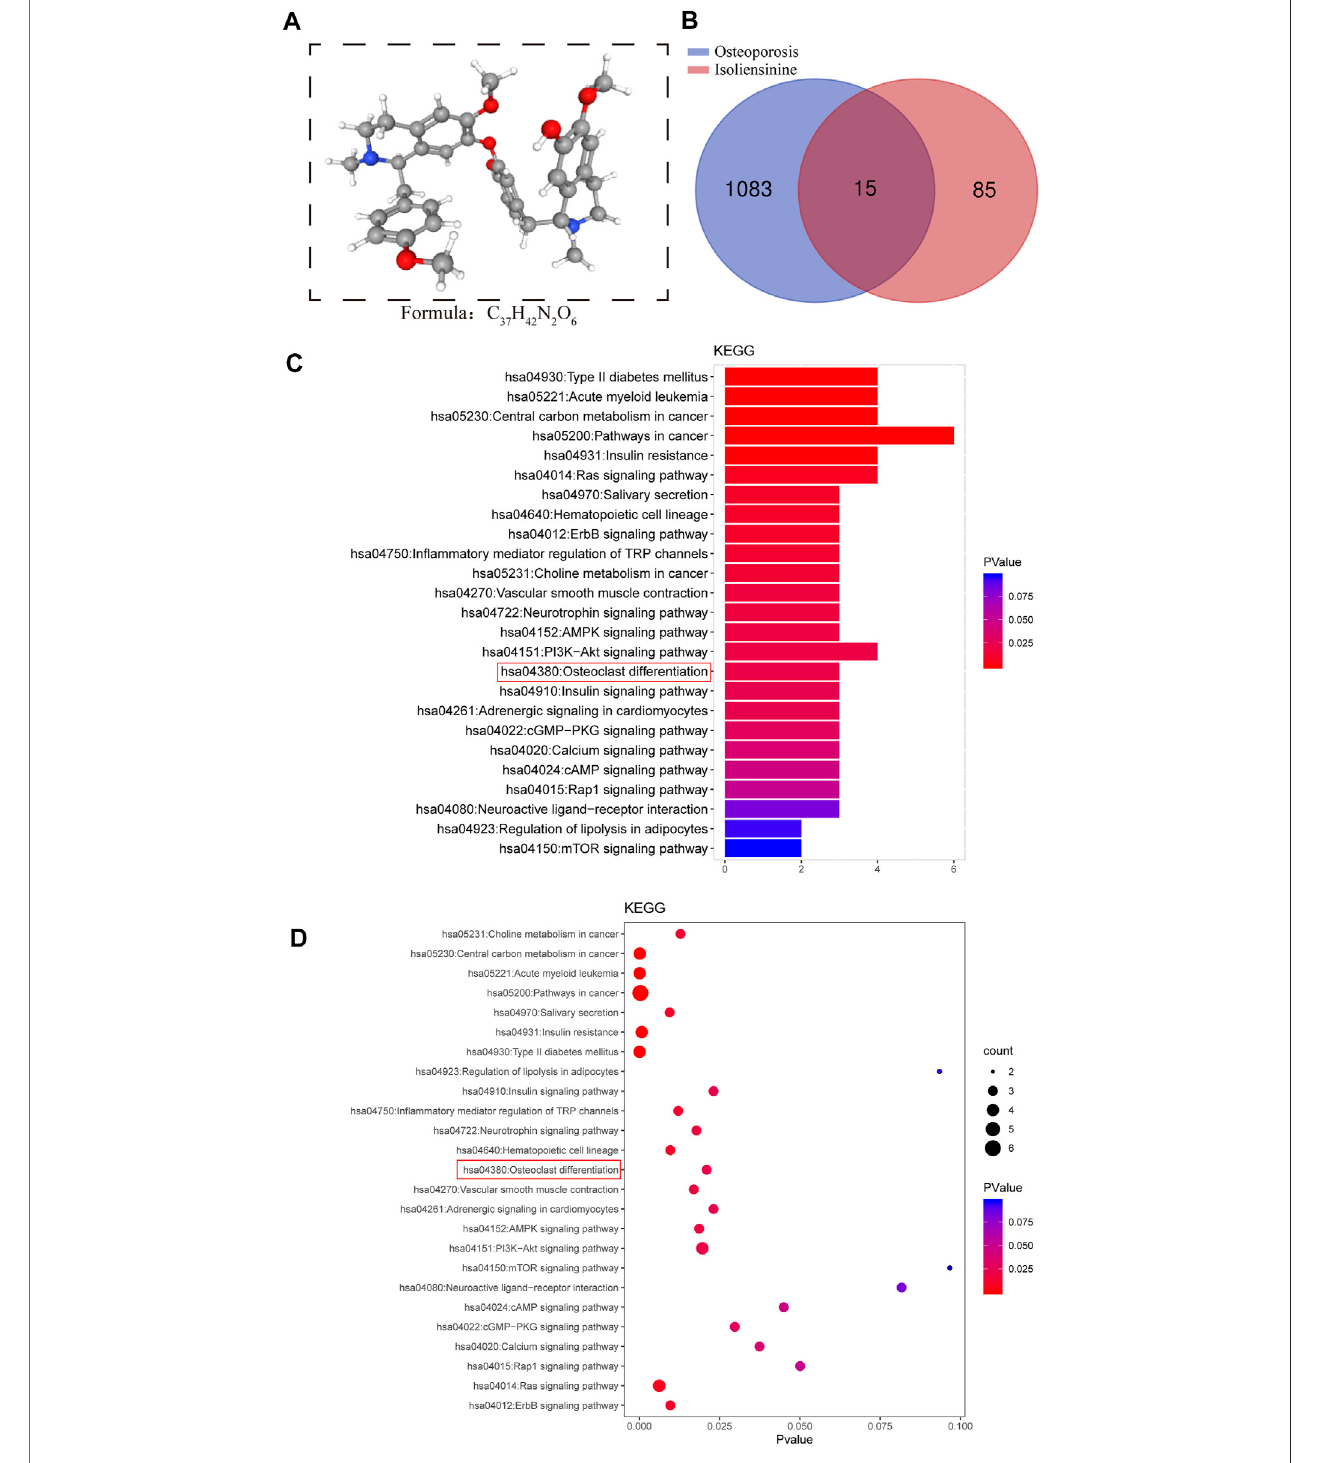
FIGURE 1 | Search for targets of Iso related to osteoporotic disease through network pharmacology. (A) The 3D chemical structure and formula of Iso (B) Venn diagram of Iso prediction targets and targets related to osteoporotic disease (C,D) KEGG enrichment analysis of Iso target genes related to osteoporotic disease. The higher the correlation, the darker the color, the larger the enrichment index, and the larger the bubble.